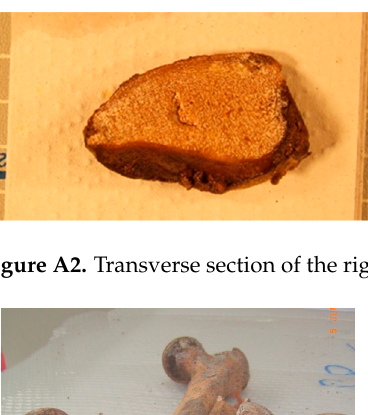
Figure A1. Right knee of the mummi fi ed body after removal of the patella. Note the thick layer of bandages around the leg.